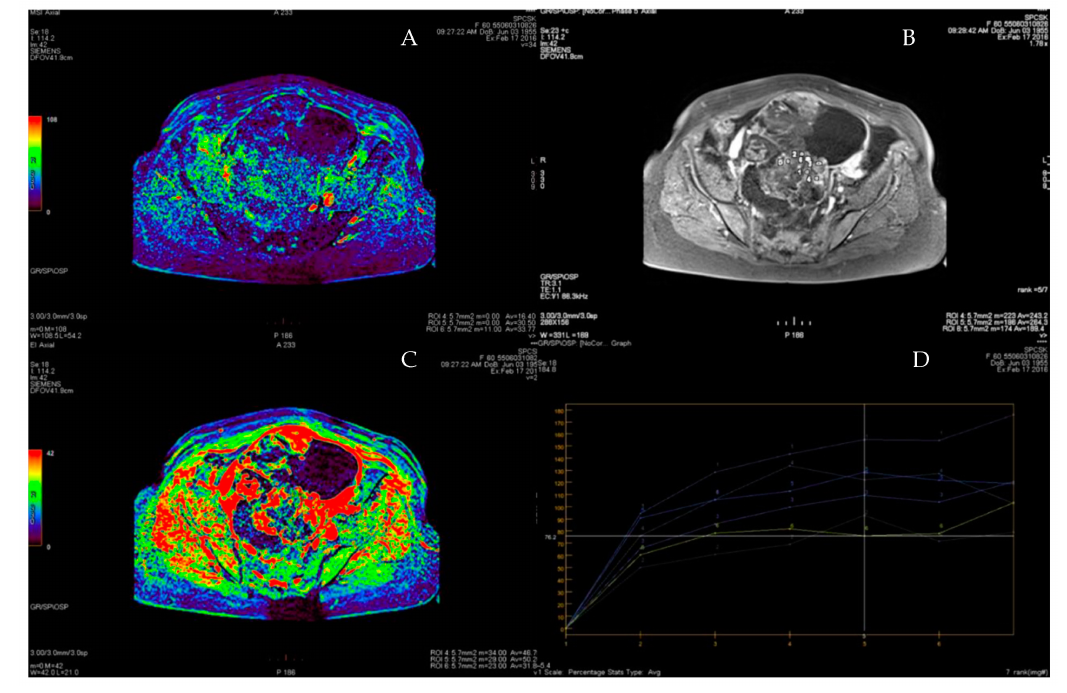
Figure 10. Images from the same 60-year-old woman with HGSC. Dynamic contrast enhancement and small ROI on intratumoral vessels. ( A – C ) Contrast enhancement curves ( D ).